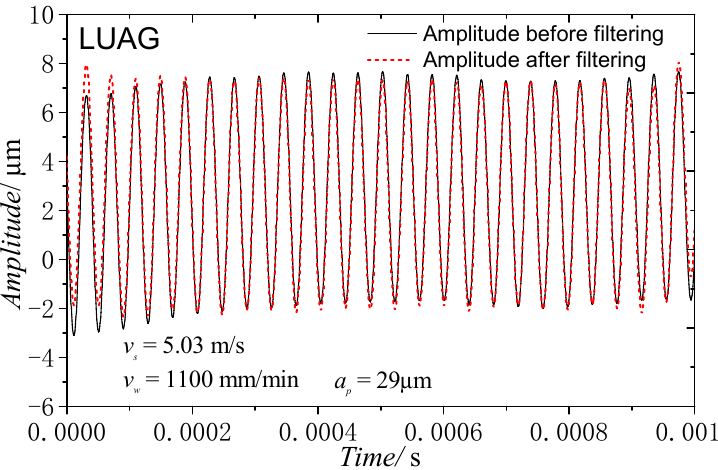
Figure 11. Amplitude curve under grinding force of ultrasonic vibration-assisted side-face grinding. To study the effect of torsional vibration in LTUAG, it was ensured that the resonant frequency and the longitudinal amplitude were the same by changing the overhang length of the tool and the output power of the ultrasonic power supply, respectively, in the com- parative experiment of LUAG and LTUAG. In the LUAG experiment, when the overhang length of the tool was 26 mm, the resonance frequency of the longitudinal ultrasonic tool holder was 24.4 kHz. In the experiment of LTUAG, when the overhang length of the tool was 22 mm, the resonance frequency of the longitudinal–torsional coupled ultrasonic tool holder was 24.4 kHz. The ultrasonic vibration parameters of the LUAG and LTUAG experiments are listed in Table